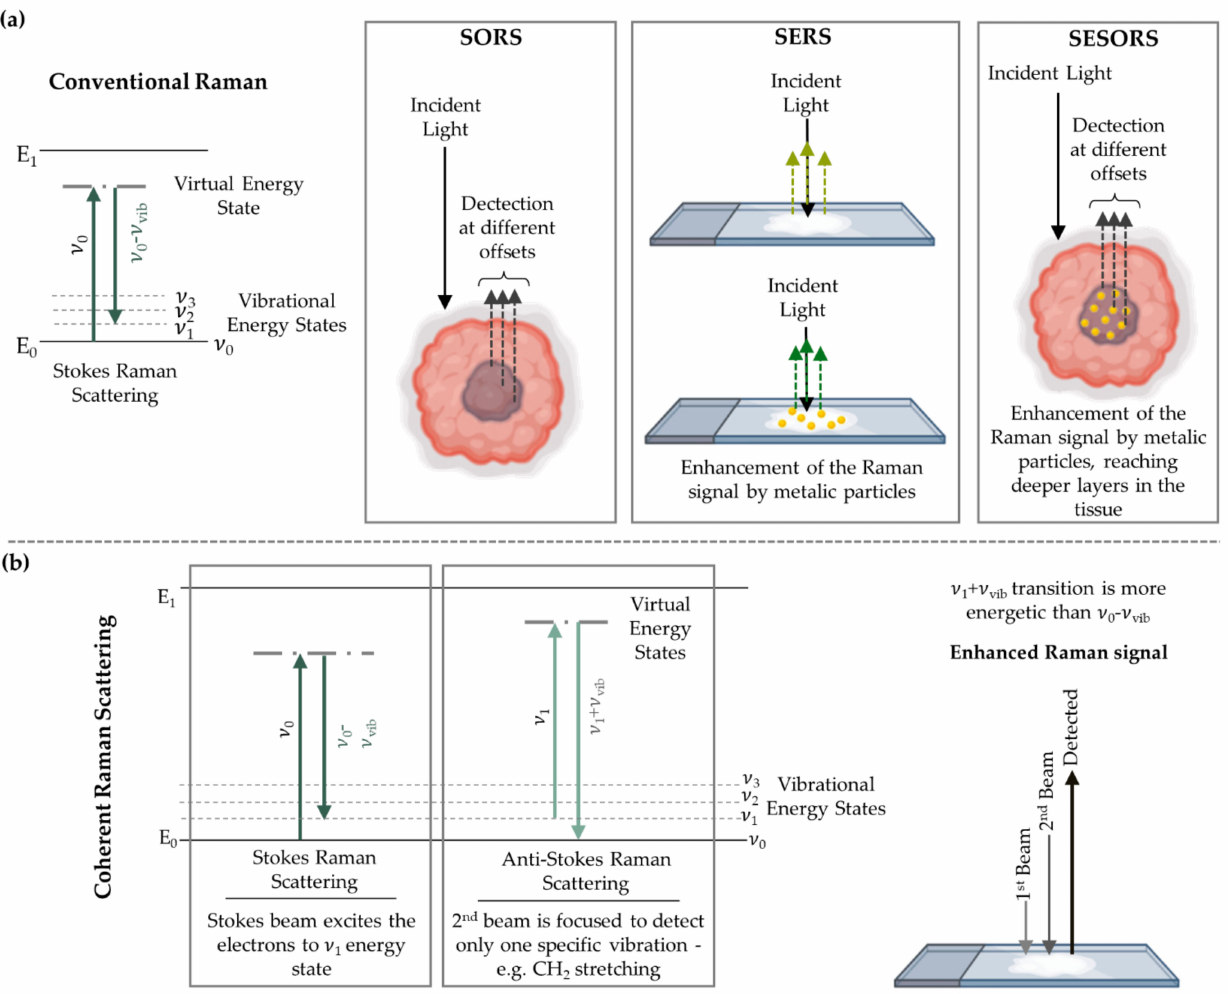
Figure 2. Schematic representation of several Raman configurations: ( a ) conventional Raman, SORS, SERS and SESORS; ( b ) coherent Raman scattering